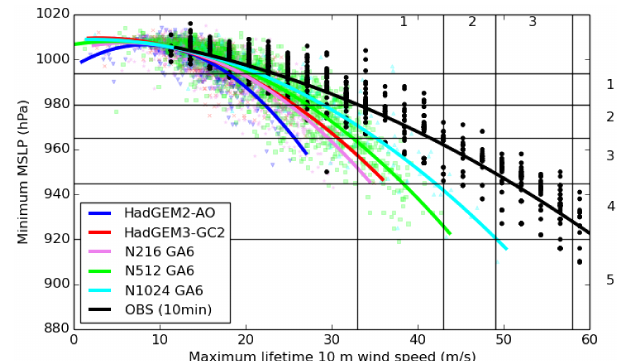
Figure 13. Scatter plot of 10m wind speed vs. central PMSL for tropical cyclones in HadGEM2-AO and HadGEM3-GC2 CLIM simulations. Also shown are GA6 atmosphere-only (AMIP) sim- ulations at N216, N512 and N1024. Hurricane database (HURDAT, Landsea and Franklin, 2013) is in